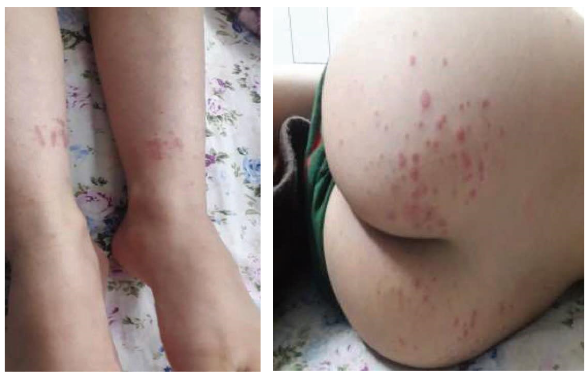
Figure 1: Palpable purpuric lesions on frst admission. Figure 2: Tree weeks later—orchitis and ulcerative lesions in the buttocks.